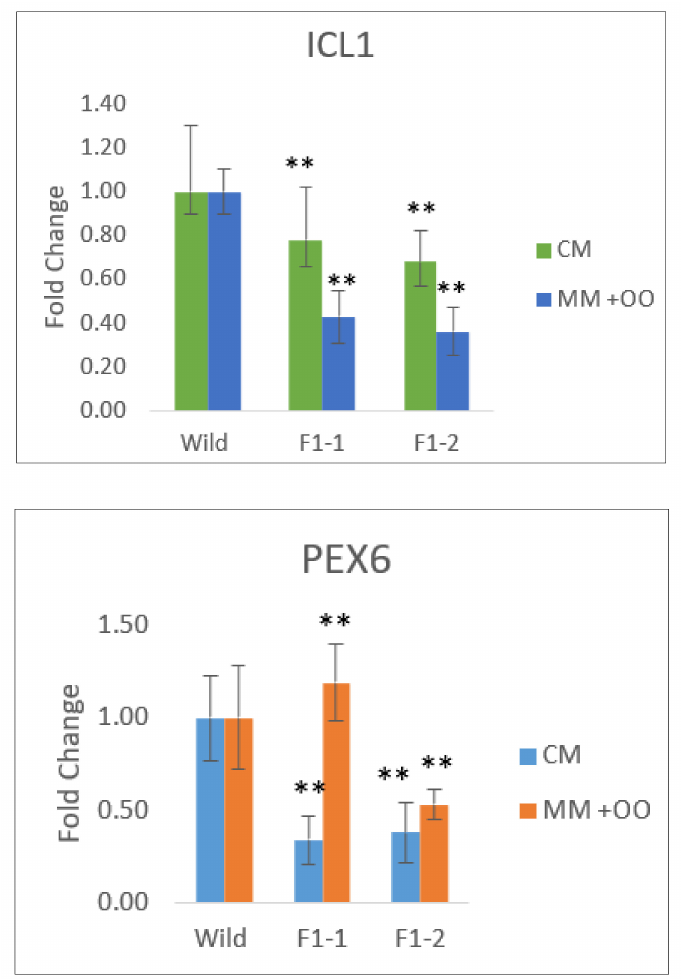
Figure 9. Gene expression of PEX6 and ICL1 expression in the wildtype strain S6, ∆ fas1-1 and ∆ fas1-2 mutants grown in complete media for 48 h and then transferred to a new flask of complete medium, or minimal medium containing 50 mM olive oil for 24 h. Expression profiles of PEX6 (peroxisomal biogenesis) and ICL1 (glyoxylate cycle) genes were analyzed. Gene expression data of PEX6 and ICL1 , obtained from quantitative RT-PCR analysis, were normalized by using with housekeeping gene EF1 α as an internal control, calculated using three independent biological experiments with three technical replicates for each independent experiment, as reported above. Double asterisks represent significant di ff erence (** p ≤